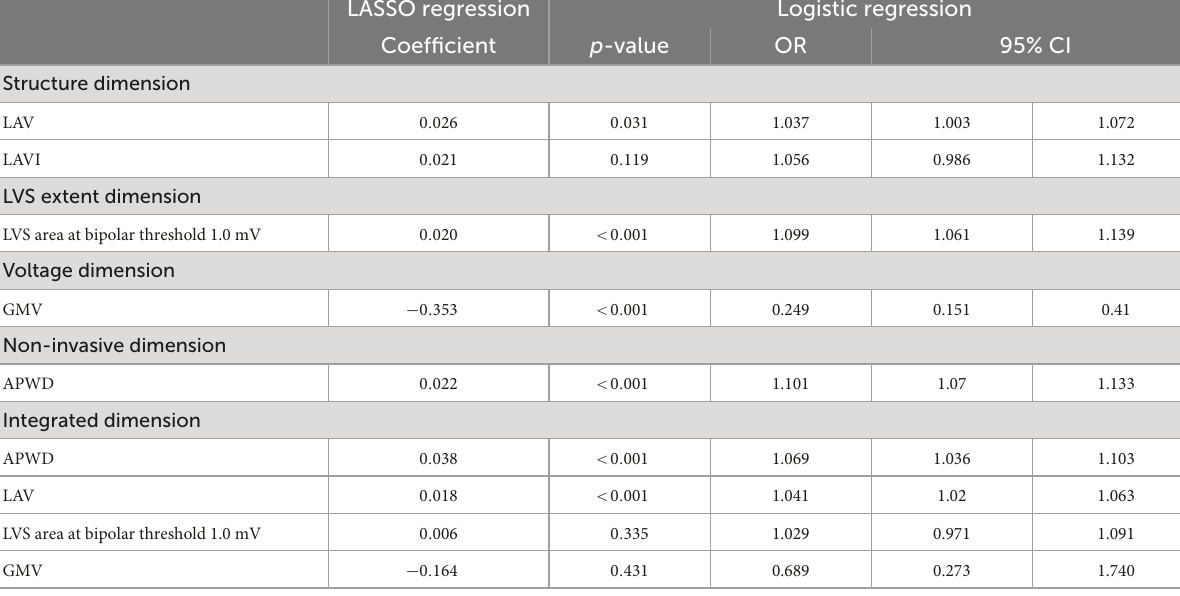
TABLE 3 Results from LASSO and logistic